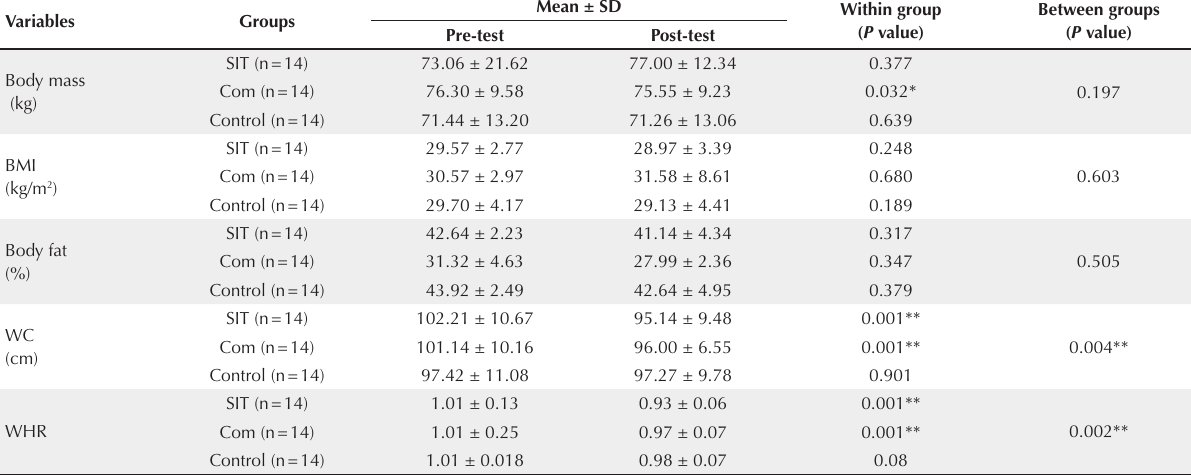
Table 2. The comparison of changes in the anthropometric variables before and after 10 weeks of exercise training Variables Groups Body mass (kg)